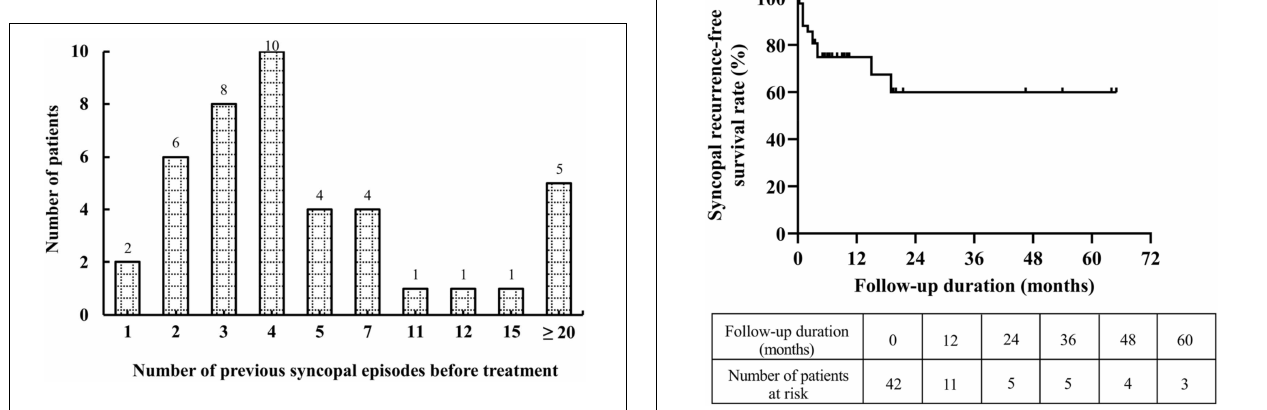
FIGURE 2 | Trend of the syncopal recurrence-free survival rate in all eligible patients over time. The y -axis represents the survival rate for non-recurrence of syncope; the x -axis represents follow-up